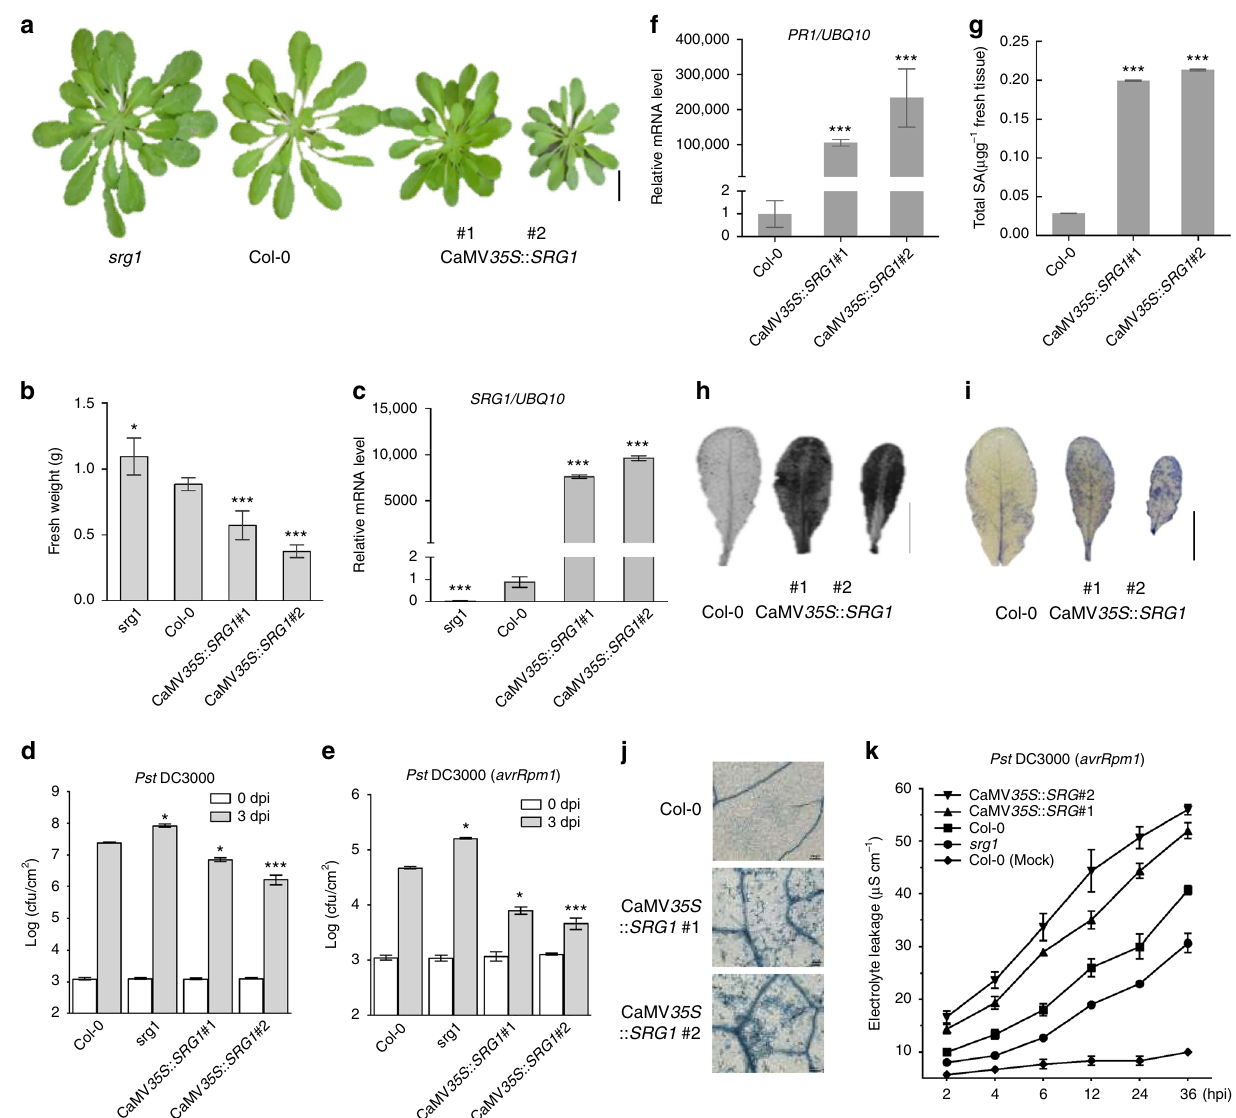
Fig. 2 SRG1 is a positive regulator of plant immunity. a Morphological phenotype of CaMV 35S :: SRG1 overexpression lines. The indicated lines were soil- grown under short day conditions and photographed at 6-weeks-old. Scale bar, 2 cm. b , c The fresh weight ( b ) and mRNA level of SRG1 ( c ) in the stated Arabidopsis lines. Error bars represent ± SD from 3 – 6 biological replicates ( t -test, *** P < 0.001, * P < 0.05, signi fi cantly different from Col-0). d , e Titre of Pst DC3000 ( d ) and Pst DC3000( avrRpm1 ) ( e ) in the indicated plant genotypes at 0 days post in fi ltration (dpi) and 3 dpi. Error bars represent ± SD from 6 biological replicates and student t -test shows signi fi cant difference from Col-0 (*** P < 0.001, * P < 0.05). f Pathogenesis-related 1 ( PR1 ) gene expression determined by quantitative real-time polymerase chain reaction (qRT-PCR) in the indicated plant lines. Error bars indicate ± SD ( n = 3 and *** P < 0.001 by t -test compared with Col-0). g Total salicylic acid (SA) levels in the given plant genotypes. Error bars indicate ± SD ( n = 3 and *** P < 0.001 by t - test compared with Col-0). h , i Accumulation of hydrogen peroxide and superoxide detected by either 3,3 ′ -diaminobenzidine (DAB) ( h ) or nitro blue tetrazolium (NBT) ( i ) staining, respectively, in the given plant lines. Scale bar, 0.5 cm. j Cell death development was scored by trypan blue staining. Scale 3 biological replicates. Asterisks indicate a signi fi cant difference compared with Col-0 (student t -test, *** P < 0.001, * P <